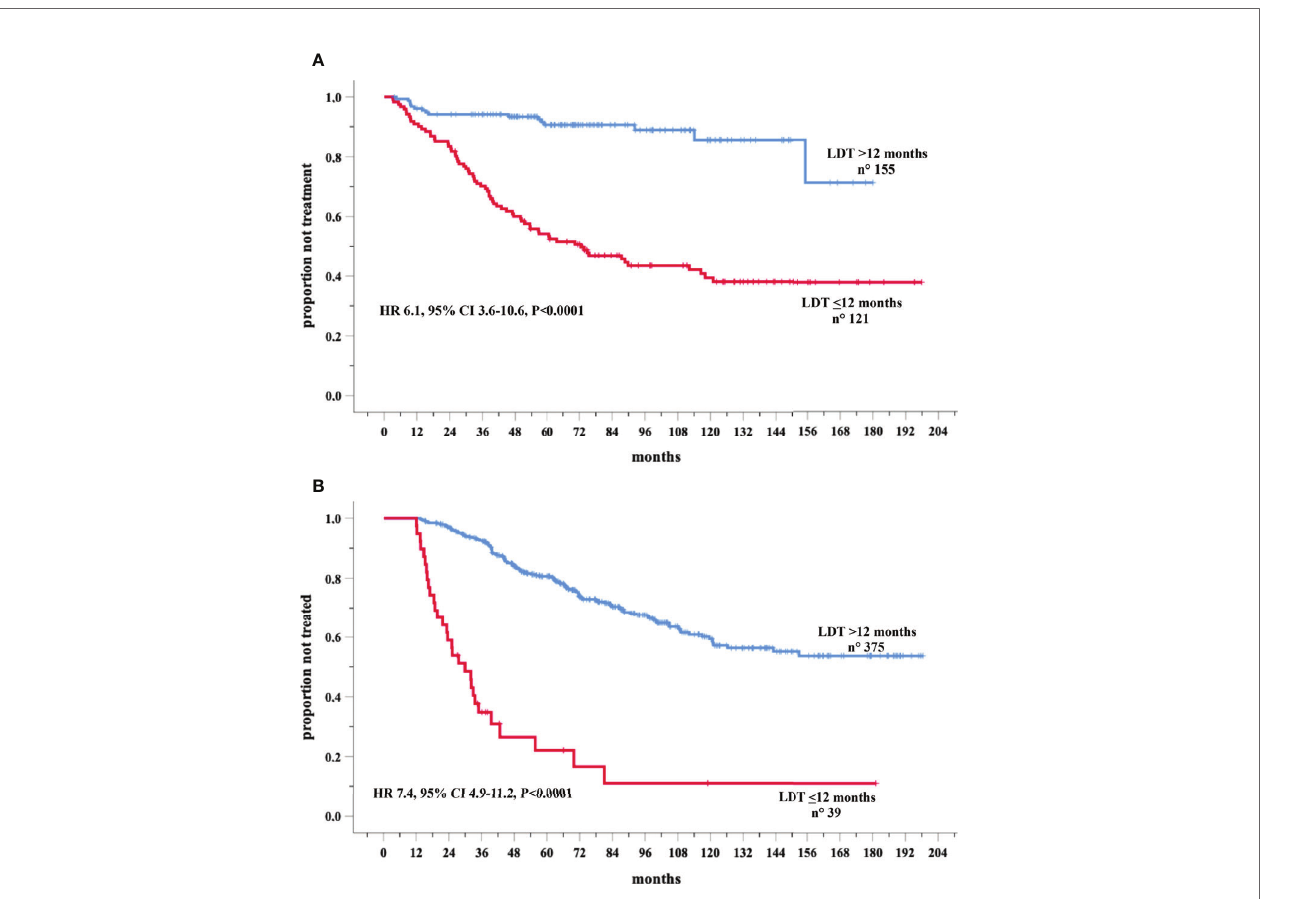
FIGURE 4 | Kaplan-Meir curvesoftimeto fi rsttreatment(TTFT)ofpatientsstrati fi edbylymphocyte doubling time(LDT)intheNovara (A) andBarcelona (B) validationcohorts.